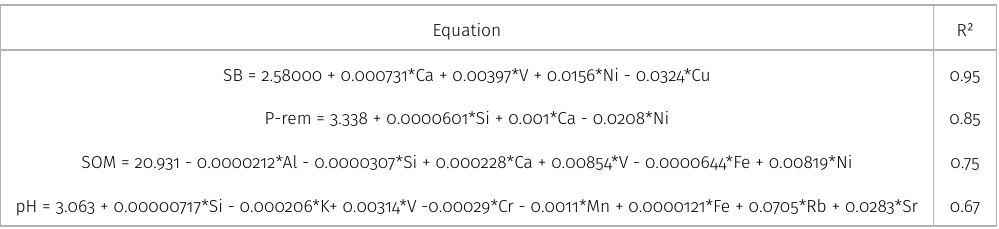
Table III. Prediction equations for sum of bases (SB), remaining P (P-Rem), soil organic matter (SOM) and pH obtained by SMLR from soil samples collected at Lavras, Minas Gerais,